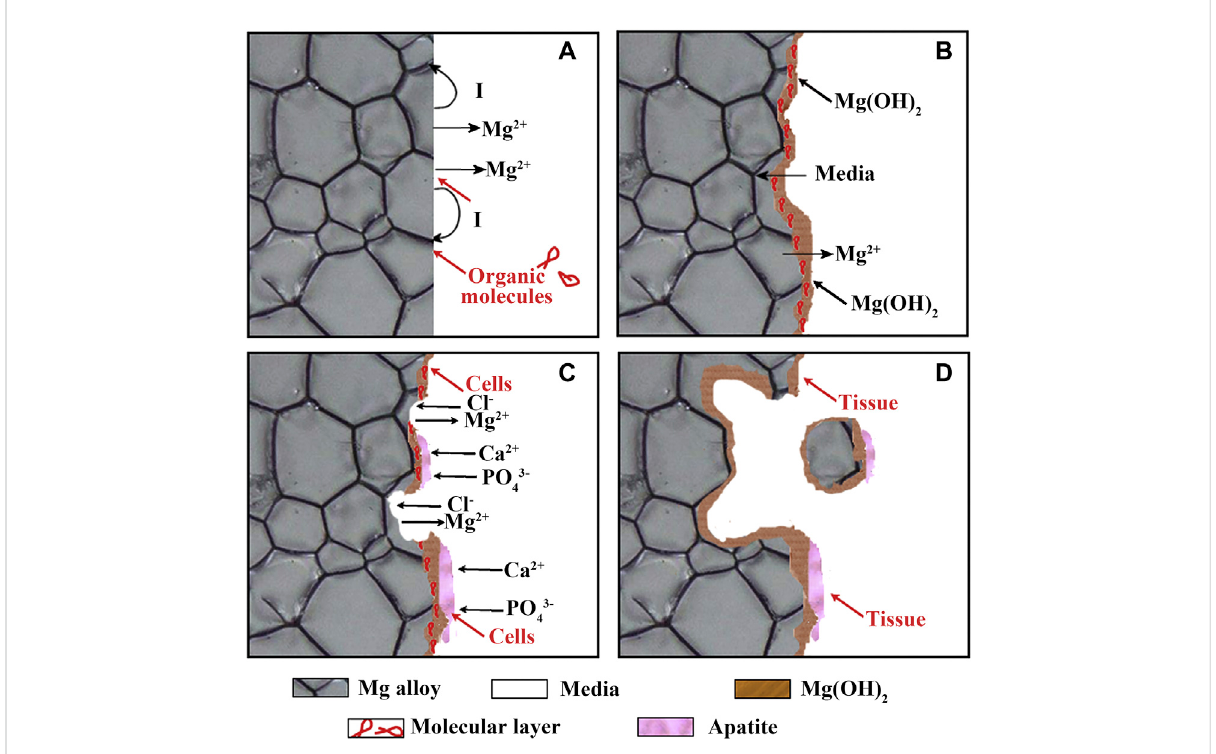
FIGURE 1 (A – D) Schematic illustration of the biocorrosion at the interface between Mg and medium. Reprinted with permission from reference (Zheng et al., 2014),